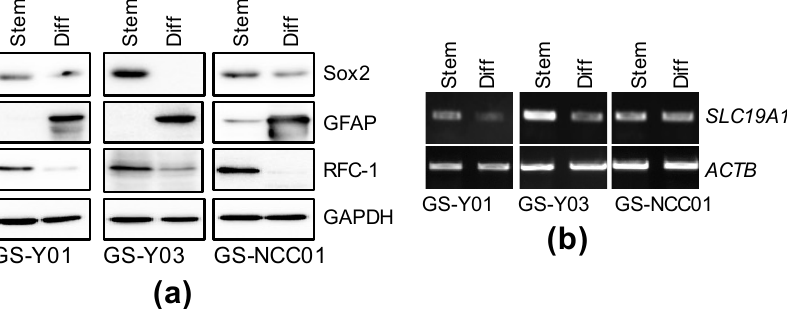
Figure 4. The expression of RFC-1/SLC19A1 in GSCs is reduced by differentiation. GSCs (GS-Y01, GS-Y03, and GS-NCC01; Stem) and differentiated GSCs (Diff) were analyzed by immunoblotting ( a ) or RT-PCR ( b ) for the indicated proteins or mRNAs. Representative images of two biological replicates are shown.